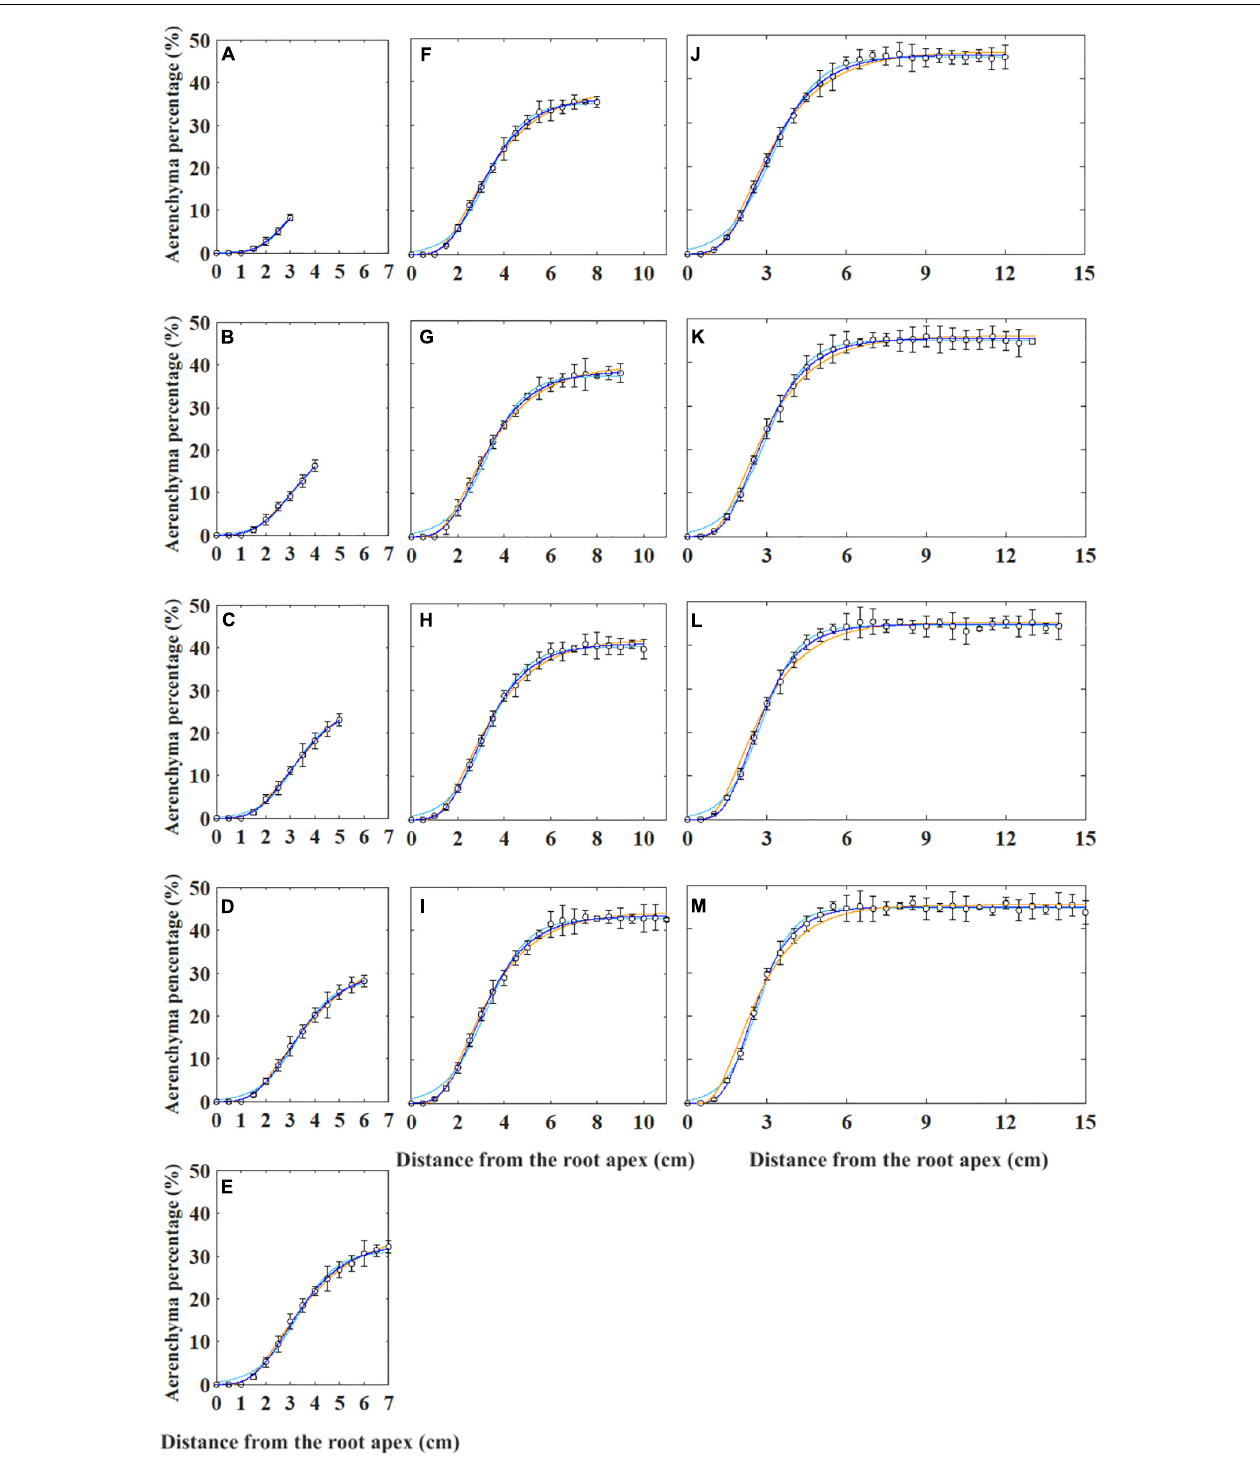
FIGURE 2 | Non-linear models fitting for the percentage of aerenchyma area to the cross-sectional area (i.e., aerenchyma percentage) in rice adventitious roots with different lengths from 4 to 16 cm (A–M) . The hollow circles and bars represent the means of the observed aerenchyma percentage ( n = 12). The lines in blue, sky blue, and orange represent the non-linear model fitting for the aerenchyma percentage with the Gompertz (i.e., W 0 -Gompertz and Ti-Gompertz), logistic, and von Bertalanffy models, respectively. The values of the 1-cm segment at the basal part of all roots were omitted.